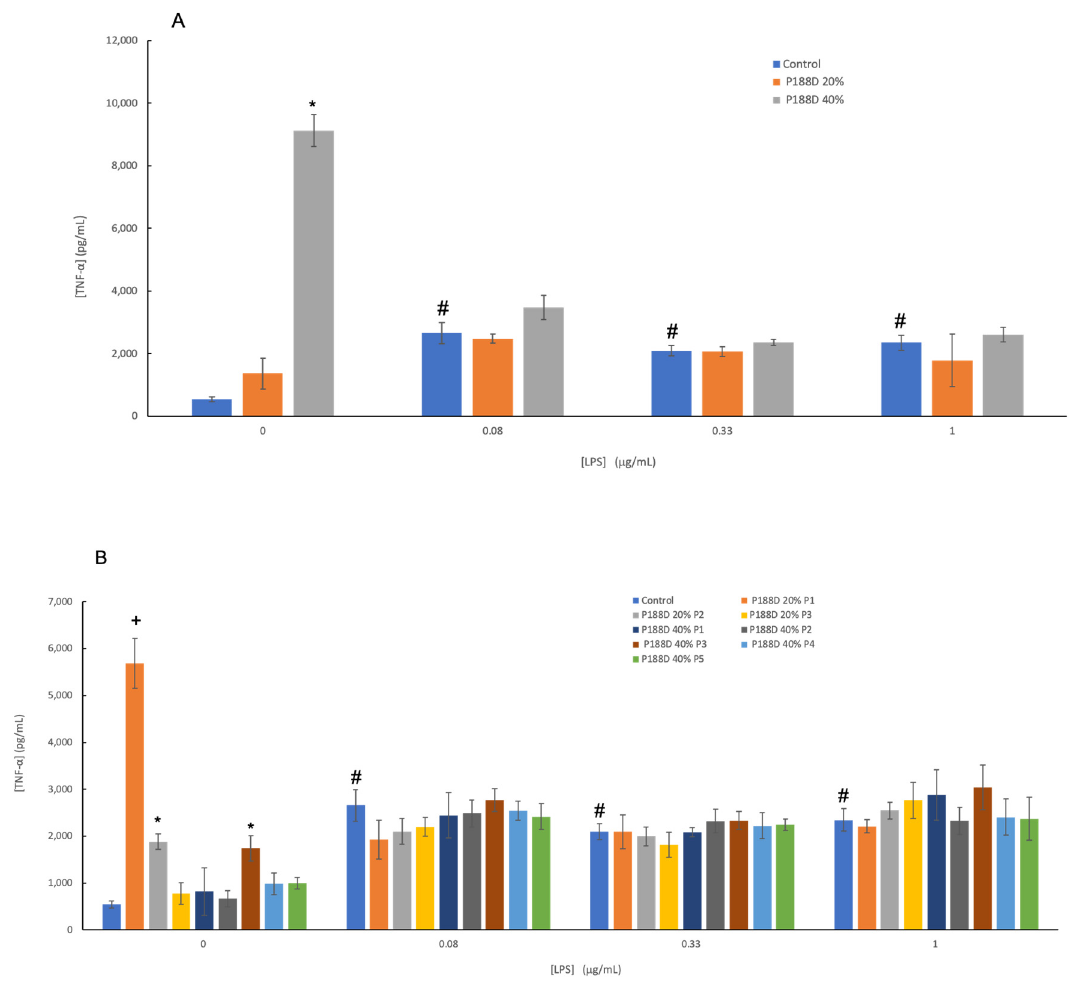
Figure 4. TNF- α release in the presence of the different fractions of the peptide ( A ) 20% and 40% fraction and ( B ) 20% P1, P2, P3 and 40% P1, P2 and P3, P4, P5 in the presence of different concentrations of LPS. * shows statistical difference in comparison to the control and + shows statistical difference in comparison to all other conditions. # shows statistical difference in comparison to the control of 0 mg/mL LPS ( p < 0.05). The error bars represent the standard